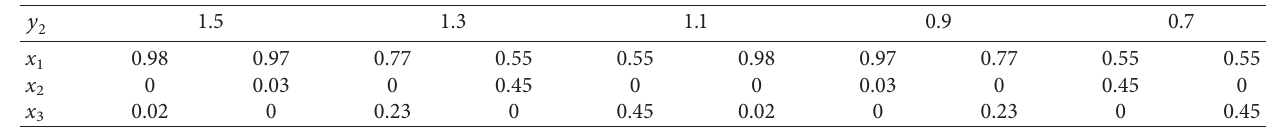
Table 15: Standard deviation y 3 regression equation